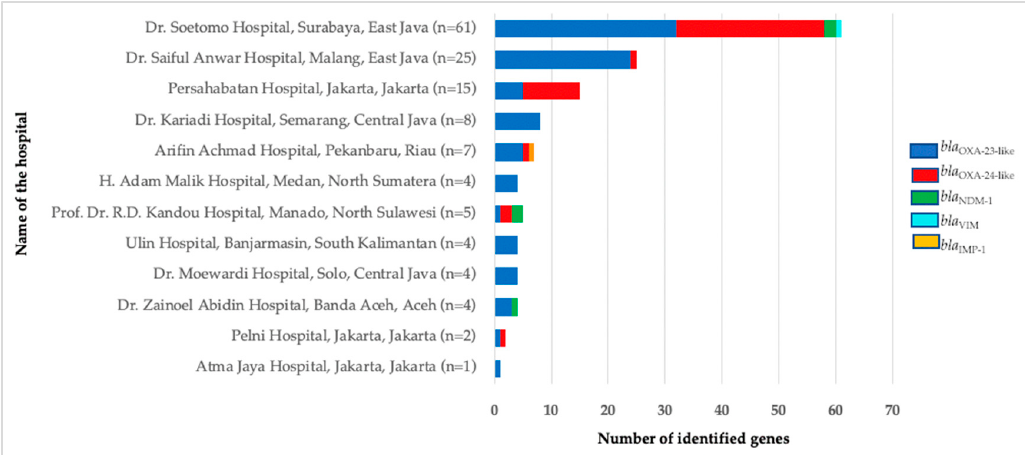
Figure 3. Carbapenemase genes’ distributions identified from 110 CNSAB isolates in 12 hospitals in Indonesia ( n = 140). There are 140 genes identified from 110 isolated CNSAB. IMP: imipenemase, NDM: New Delhi metallo-beta-lactamase, OXA: oxacillinase, VIM: Verona integron-encoded metallo-beta-lactamase.